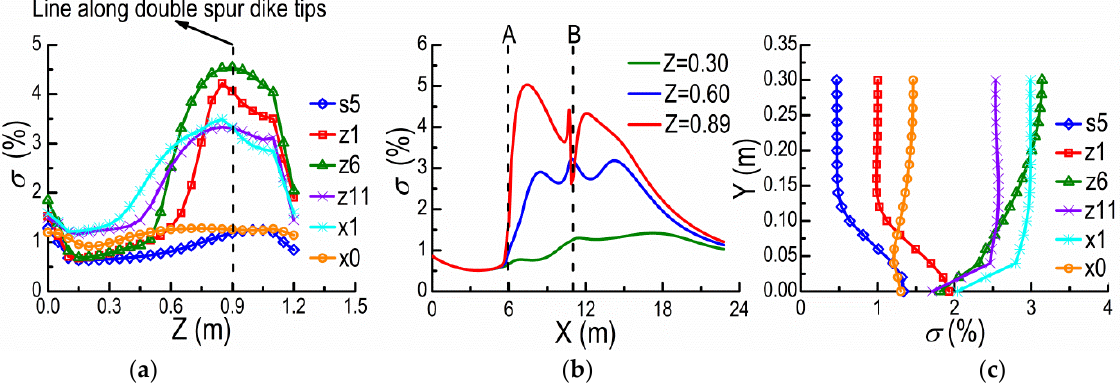
Figure 8. Turbulence intensities along different directions. ( a ) Along Z-direction (Y = 0.08 m). ( b ) Along X-direction (Y = 0.08 m). ( c ) Along Y-direction (Z = 0.6